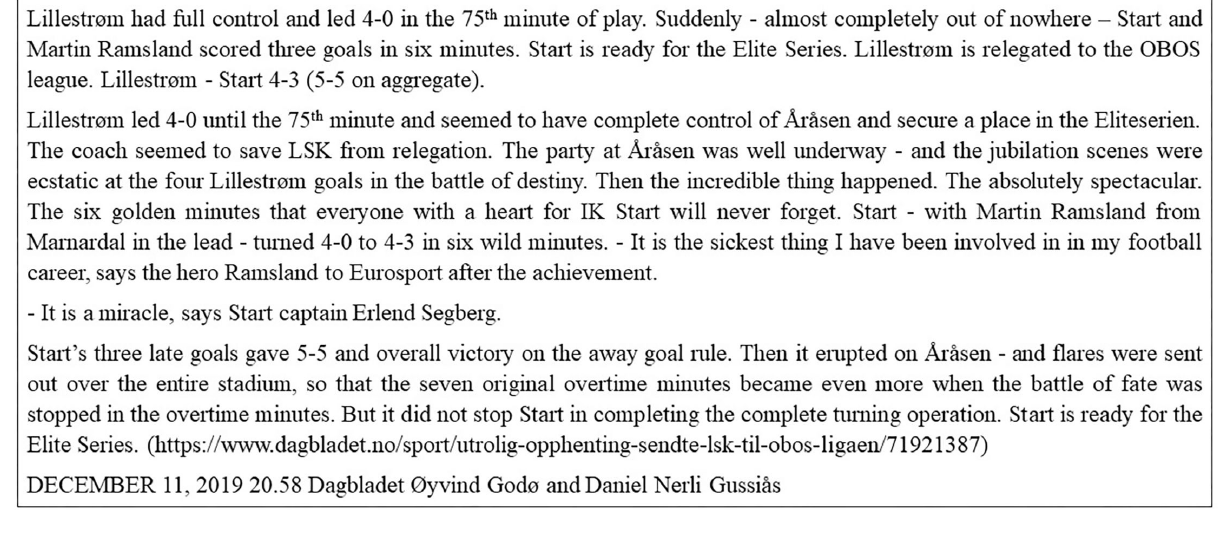
FIGURE 1 | Report in the daily newspaper (translation conducted by the authors). Published with permission from